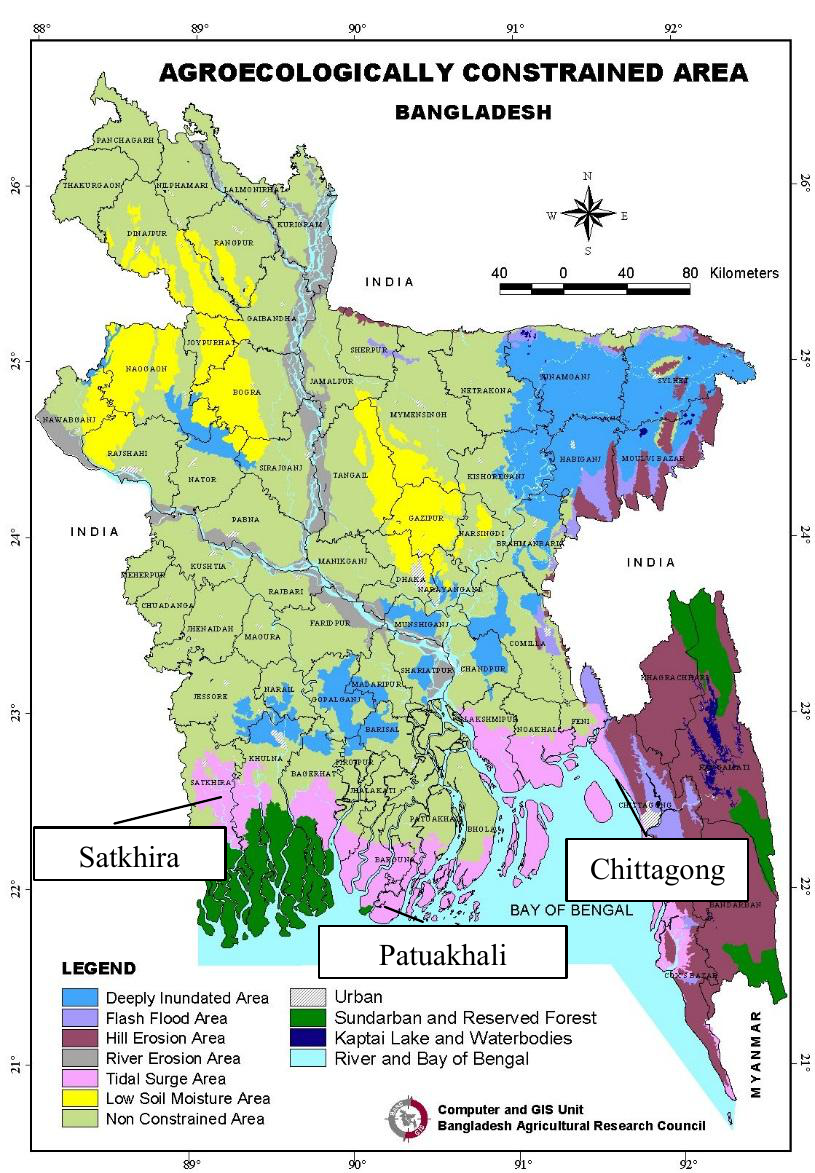
Plate 1: Three experimental sites and tidal surge (saline prone) areas of